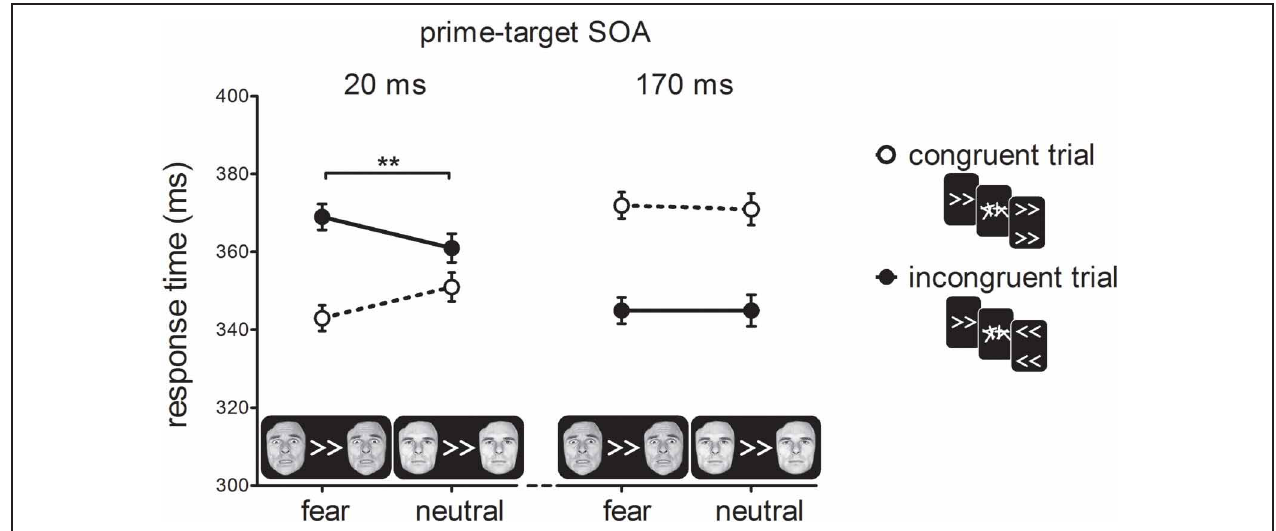
FIGURE 3 | Response times in milliseconds (ms) for the experimental conditions in Experiment 1. For compatible trials, prime, and target arrows elicited the same response, whereas for incompatible trials they